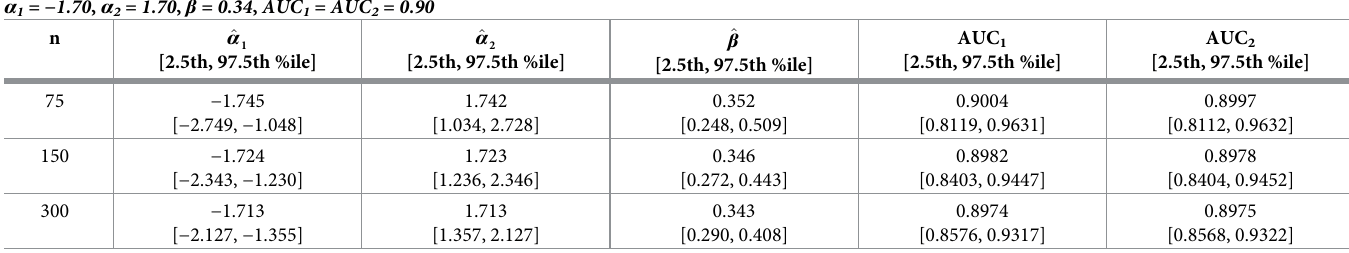
Table 2. Proportional odds simulation. Parameter estimates and AUCs realized from cumulative ROC curve analysis of 10,000 simulated datasets parameterized with proportional odds and AUC 1 = AUC 2 =